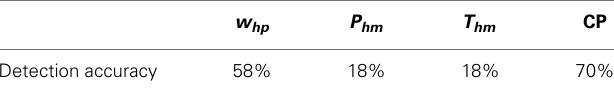
Table 5 |Thermal fault detection by sensors of hydraulic subsystem . w hp P hm T